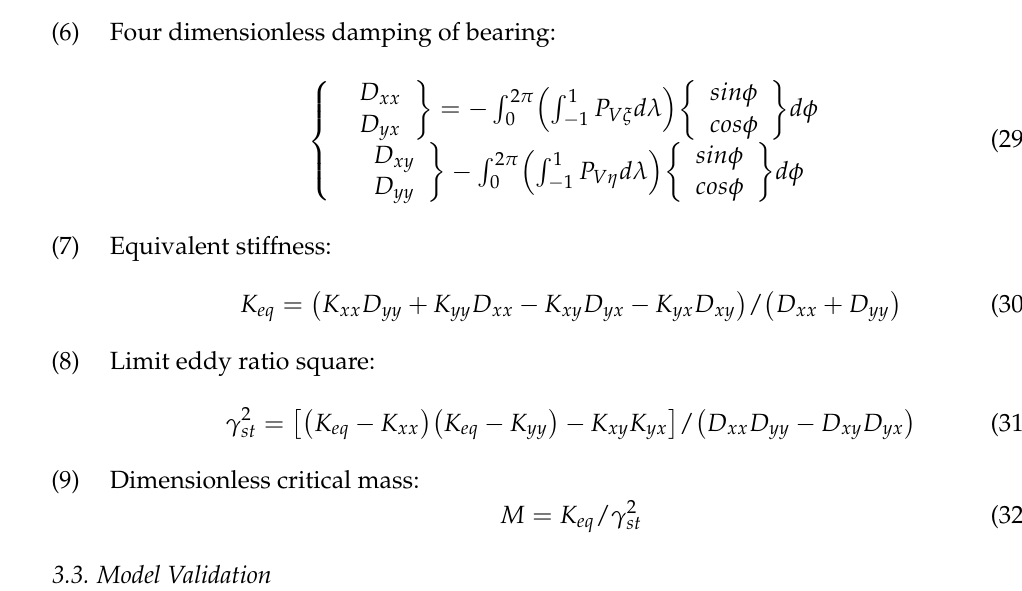
Table 1. The parameters of V-g B.